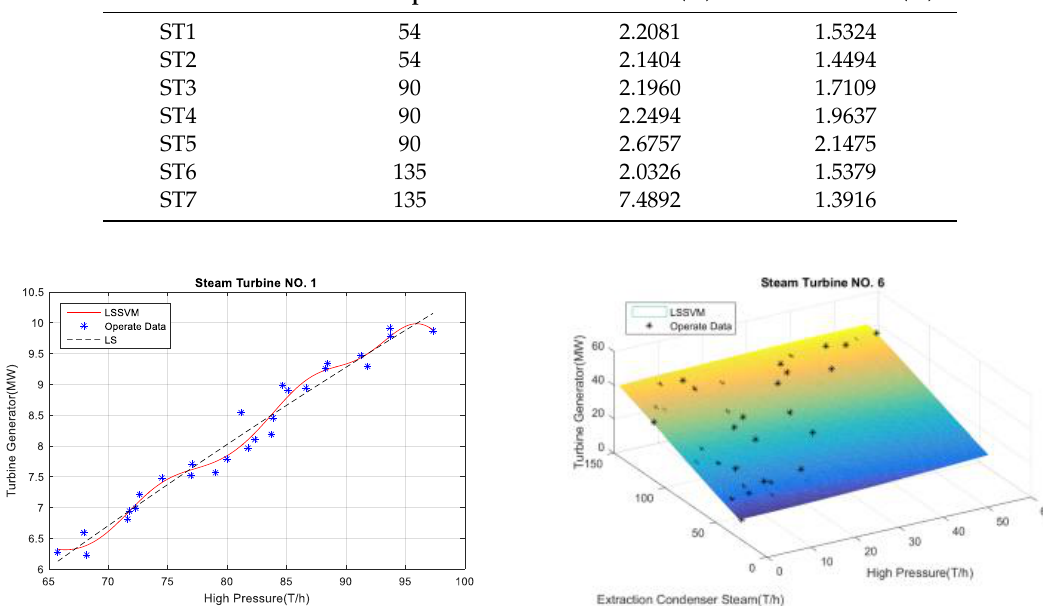
Table 5. The error results for the operation model of steam turbines. Unit No.